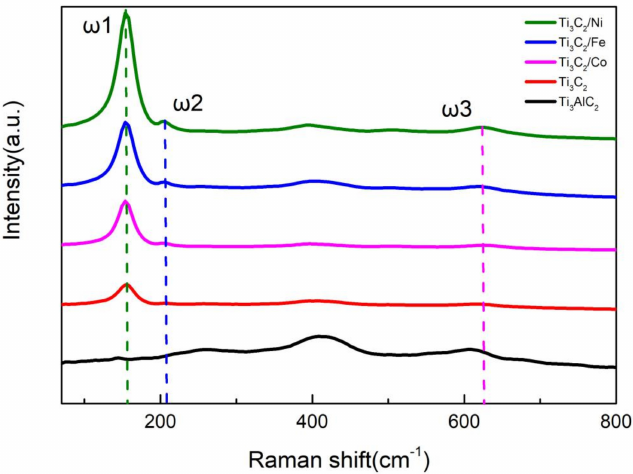
Figure 5. Raman spectra of Ti 3 AlC 2 , Ti 3 C 2 , and Ti 3 C 2 /Fe 3+ /Co 2+ Ni 2+